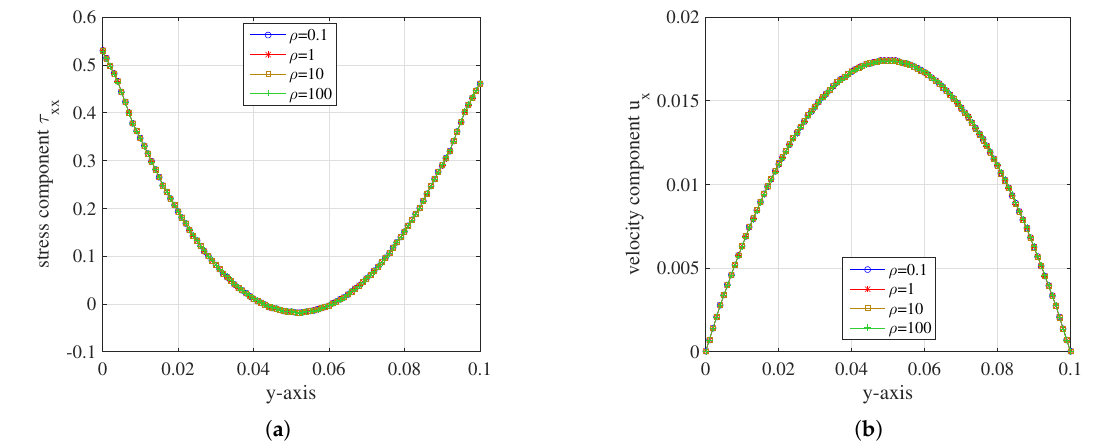
Figure 10. ( a ) Stress component τ xx ; and ( b ) velocity component u x on the y -axis during the steady state at t = 1.999185 for different Re number of FENE model.